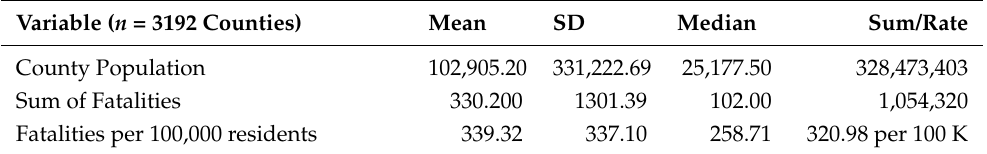
Figure 5. COVID-19 Logarithm of the Sum of Deaths (+1). Aggregated at the state level, fatality rates per 100,000 individuals (not adjusted for age) were highest in Mississippi (436.54), West Virginia (420.61), Alabama (419.28), and Arizona (414.97), while they were lowest in Hawaii (121.2), Vermont (122.28), Utah (157.99), and Alaska (184.68). Table 2 provides a complete enumeration of deaths, popu- lations, and fatality rates per 100,000, while Figure 6 provides a map of the logarithm of the sum of COVID-19 Deaths (+1) for counties where the mean is greater than the variance (N = 137). Table 2. Deaths, population, and fatality rate per 100,000 persons (sorted by fatality rate). State